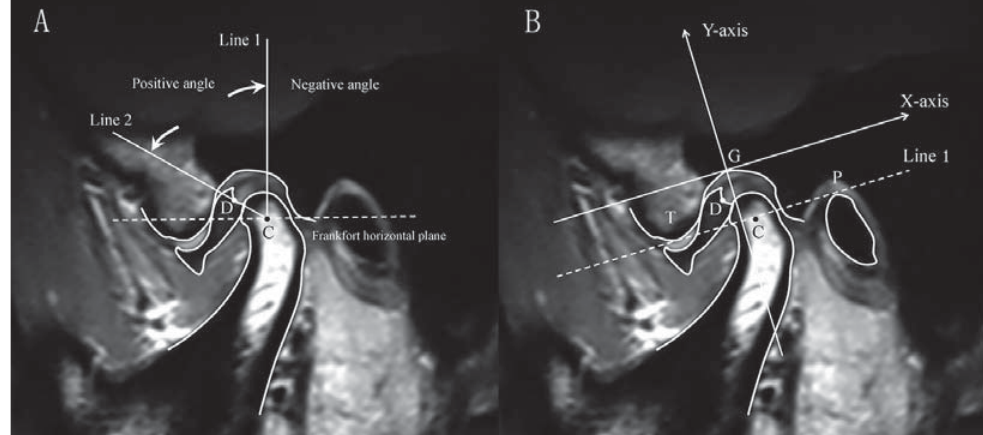
Figure 2- A: Drace’s measurement for disc-condyle angle. C point estimated the center of the condylar head. Line 1 was drawn from C point perpendicular to the Frankfort horizontal plane. Line 2 was drawn through C point to the midpoint of the posterior margin of (cid:87)(cid:75)(cid:72)(cid:3)(cid:83)(cid:82)(cid:86)(cid:87)(cid:72)(cid:85)(cid:76)(cid:82)(cid:85)(cid:3)(cid:69)(cid:68)(cid:81)(cid:71)(cid:3)(cid:82)(cid:73)(cid:3)(cid:87)(cid:75)(cid:72)(cid:3)(cid:71)(cid:76)(cid:86)(cid:70)(cid:3)(cid:11)(cid:39)(cid:3)(cid:83)(cid:82)(cid:76)(cid:81)(cid:87)(cid:12)(cid:17)(cid:3)(cid:55)(cid:75)(cid:72)(cid:3)(cid:68)(cid:81)(cid:74)(cid:79)(cid:72)(cid:3)(cid:69)(cid:72)(cid:87)(cid:90)(cid:72)(cid:72)(cid:81)(cid:3)(cid:79)(cid:76)(cid:81)(cid:72)(cid:3)(cid:20)(cid:3)(cid:68)(cid:81)(cid:71)(cid:3)(cid:79)(cid:76)(cid:81)(cid:72)(cid:3)(cid:21)(cid:3)(cid:90)(cid:68)(cid:86)(cid:3)(cid:71)(cid:72)(cid:191)(cid:81)(cid:72)(cid:71)(cid:3)(cid:68)(cid:86)(cid:3)(cid:87)(cid:75)(cid:72)(cid:3)(cid:71)(cid:76)(cid:86)(cid:70)(cid:16)(cid:70)(cid:82)(cid:81)(cid:71)(cid:92)(cid:79)(cid:72)(cid:3)(cid:68)(cid:81)(cid:74)(cid:79)(cid:72)(cid:17)(cid:3)(cid:37)(cid:29)(cid:3)(cid:38)(cid:82)(cid:82)(cid:85)(cid:71)(cid:76)(cid:81)(cid:68)(cid:87)(cid:72)(cid:3) measurement for disk and condyle position. A tangent from the lowest part of the articular tubercle (T) to the highest edge of the porus acusticus externus (P) was drawn (Line 1). The X-axis was drawn through the highest point of glenoid fossa (G), parallel to Line 1. The Y-axis was drawn from G point perpendicular to the X-axis. G point was taken as the origin of